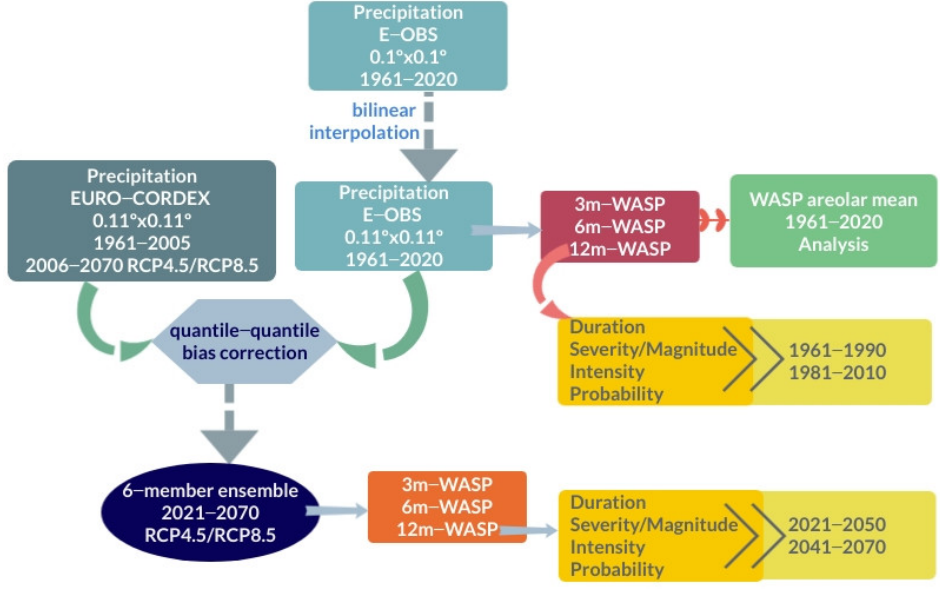
Figure 2. Schematic representation of this study methodology.